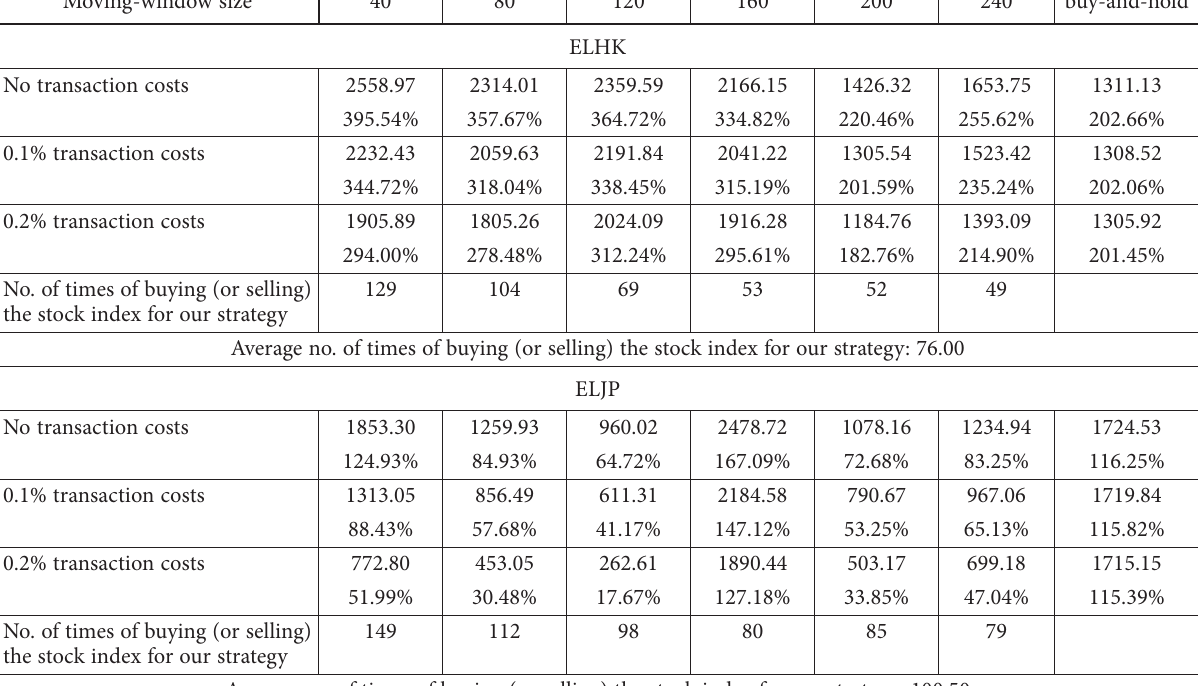
Table 3. Comparison between the profits of our strategy and “buy-and-hold” Moving-window